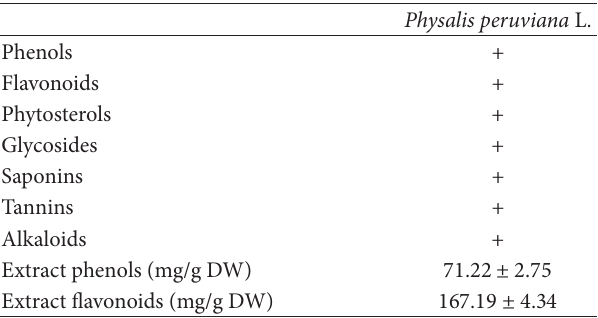
Table 1: Phytochemical screening of Physalis peruviana L. extract and its content of total phenols and